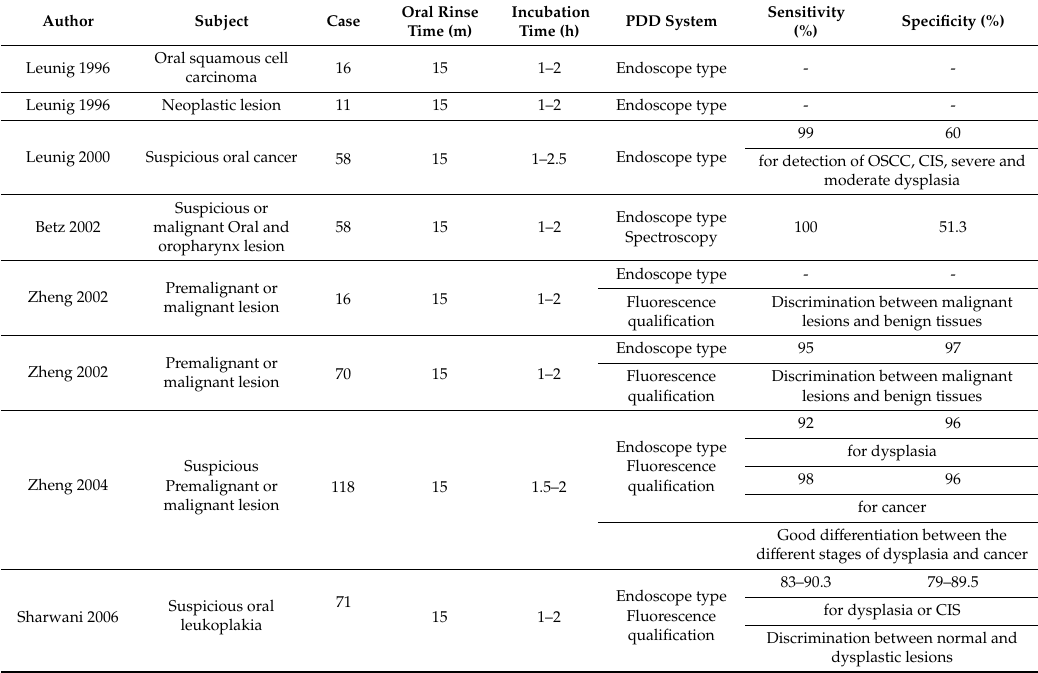
Table 2. Clinical application of ALA-PDD for oral malignant or premalignant